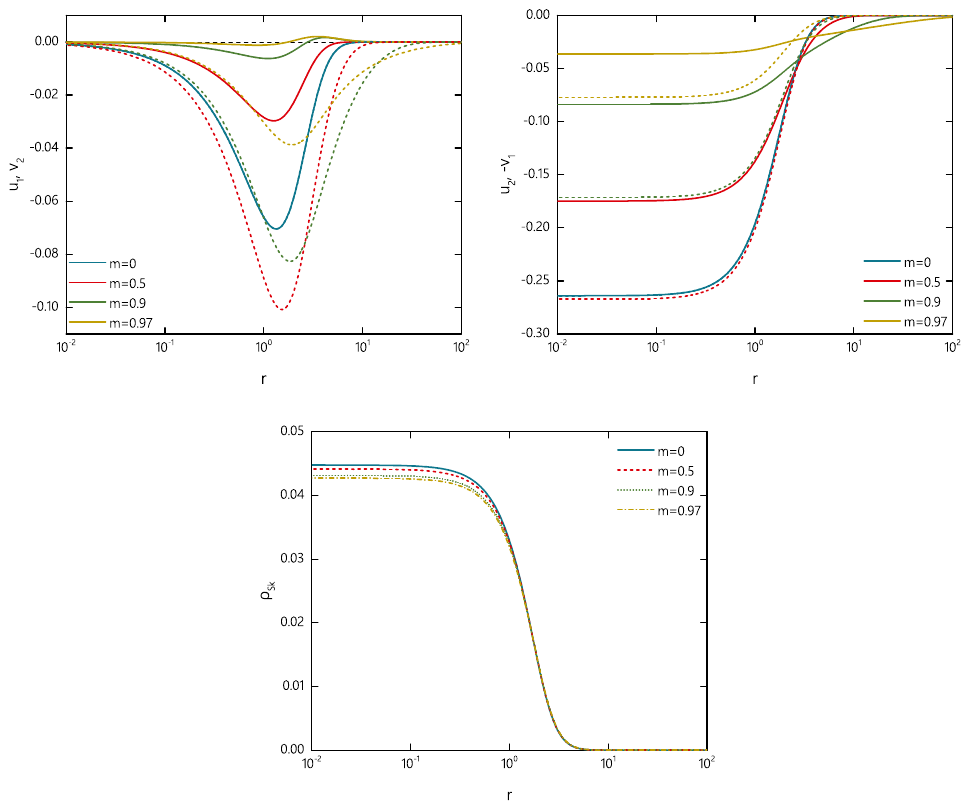
Figure 6 . Components v 1 (solid line) and u 2 (dashed line) of the fermionic mode A 0 (upper left plot), and components v 2 (solid line) and u 1 (dashed line) of the fermionic mode A 0 (upper right − plot), and the topological charge density distribution (2.4) (bottom plot) as functions of the radial coordinate r for some set of values of the fermionic mass m at g = 1 , κ 0 = 0 .